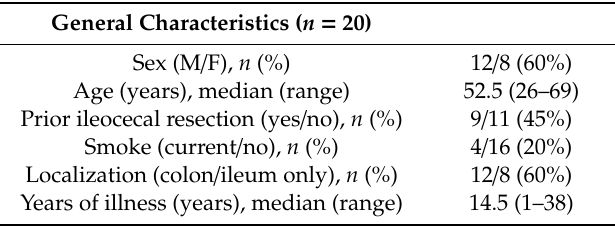
Table 1. Features of the study population.